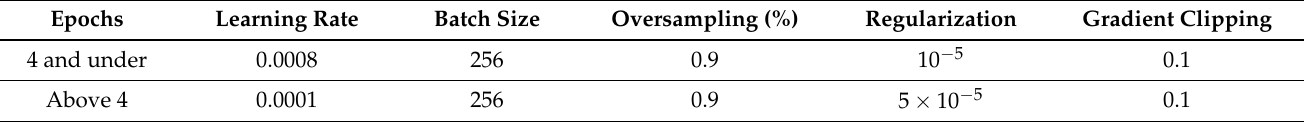
Table 2. Table of hyperparameters used to train the